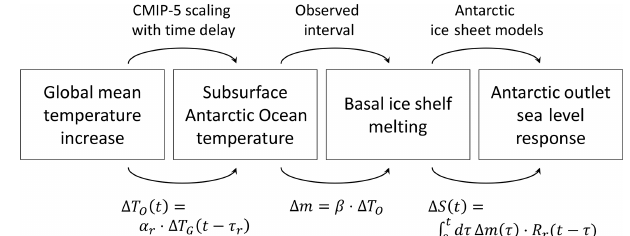
Figure 1. Schematic of the projection procedure: global mean tem- perature increase, (cid:49)T G , is transformed into a subsurface warming around Antarctica, (cid:49)T O , with a scaling coefficient, α r , and a time delay, τ r , both of which are derived for each of the five Antarctic outlet regions from 19 CMIP5 models. The basal ice shelf melt- ing rate, (cid:49)m , is then derived by multiplying the subsurface oceanic temperature with a basal melt sensitivity β . This sensitivity is ran- domly chosen from the observed interval. The basal melt rate is then convoluted with the ice sheet response function of the specific region, R r , to obtain the time series of this Antarctic outlet region.